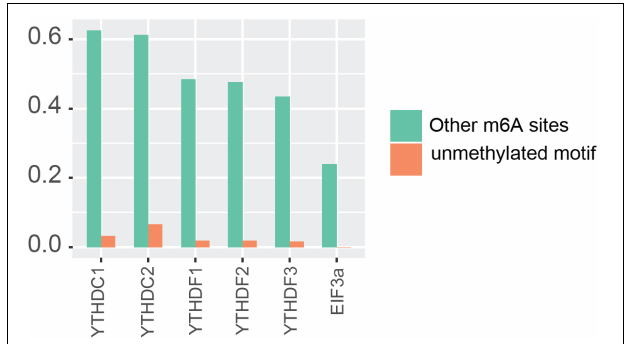
FIGURE 1 | Potential substrate of m 6 A